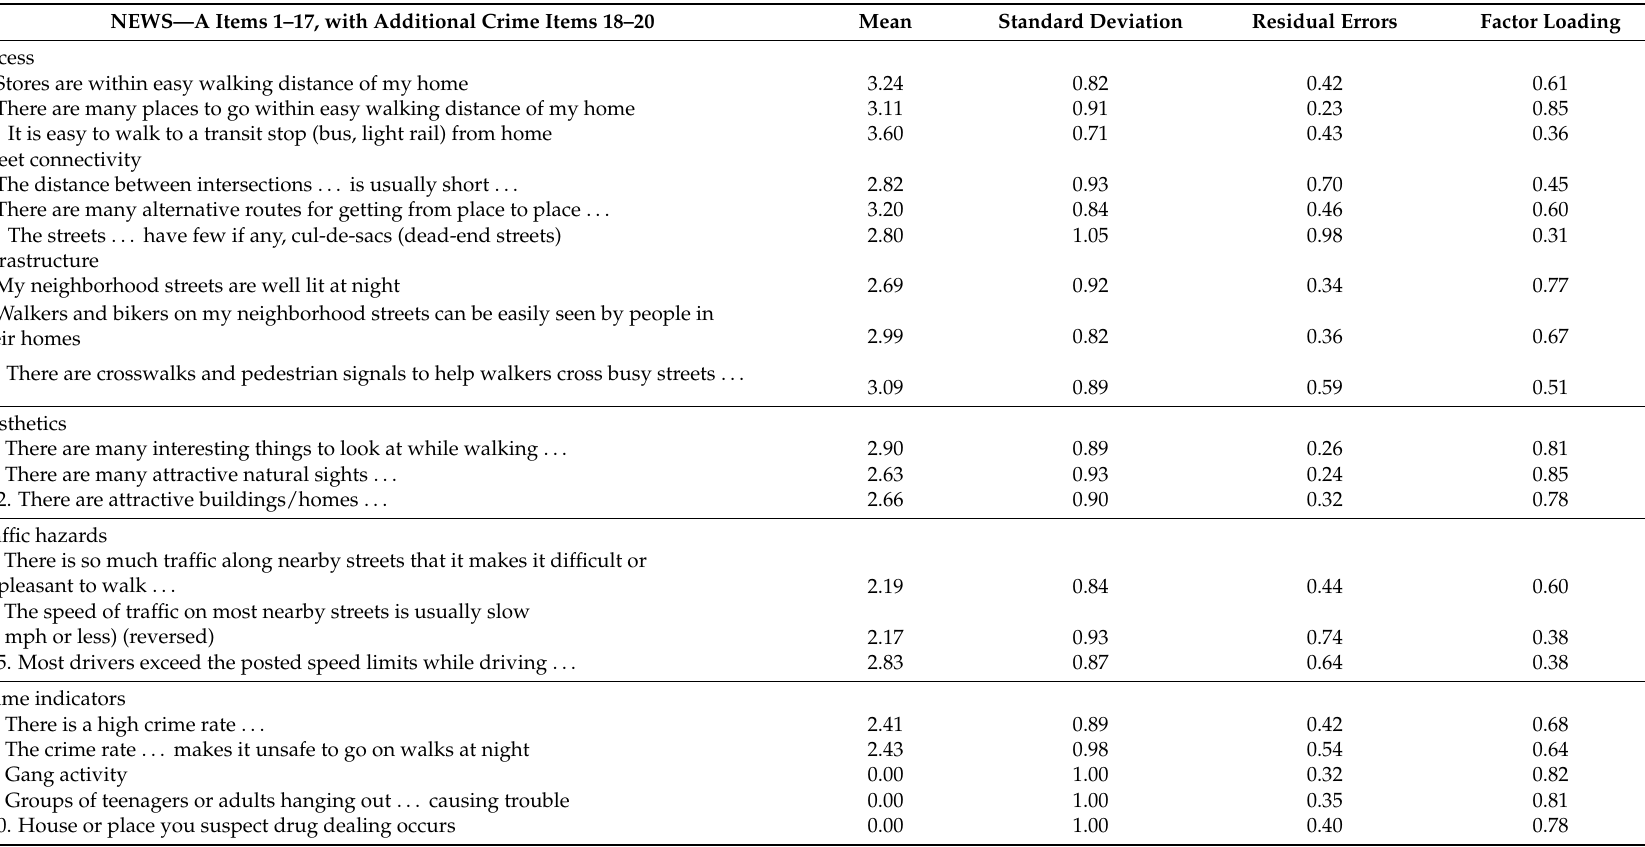
Table 1. Neighborhood Environment Walkability Scale—Abbreviated (NEWS—A), expanded: Descriptive statistics and factor loadings for six factors. NEWS—A Items 1–17, with Additional Crime Items